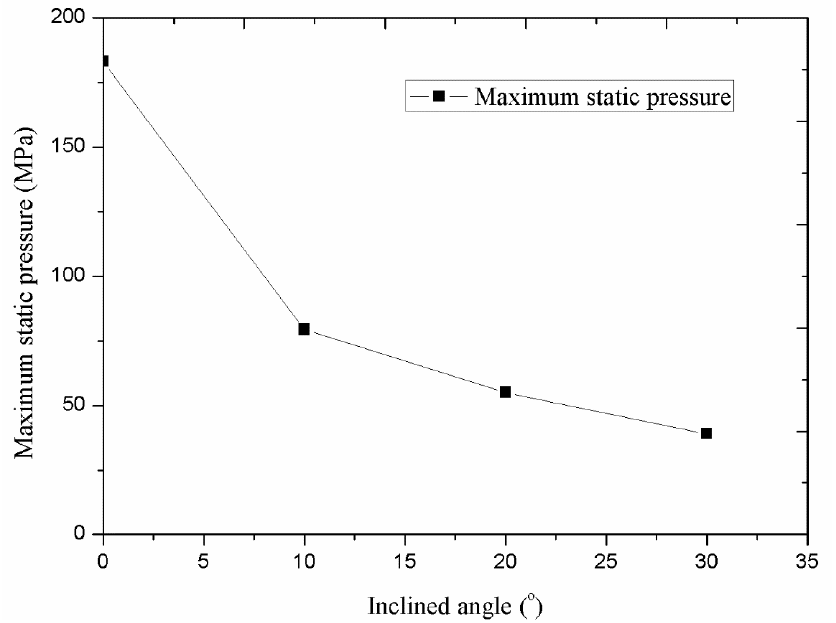
Figure 21. Influence of inclined angle on the static pressure on the target surface.